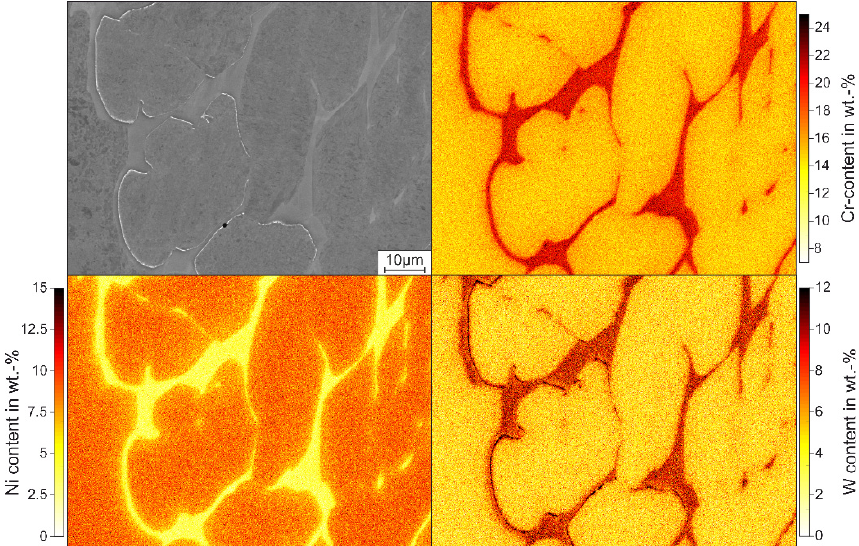
Figure 4. SEM ‐ BSE micrograph and the local element concentrations of Cr and Ni in the X2CrNi18 ‐ 9 steel.